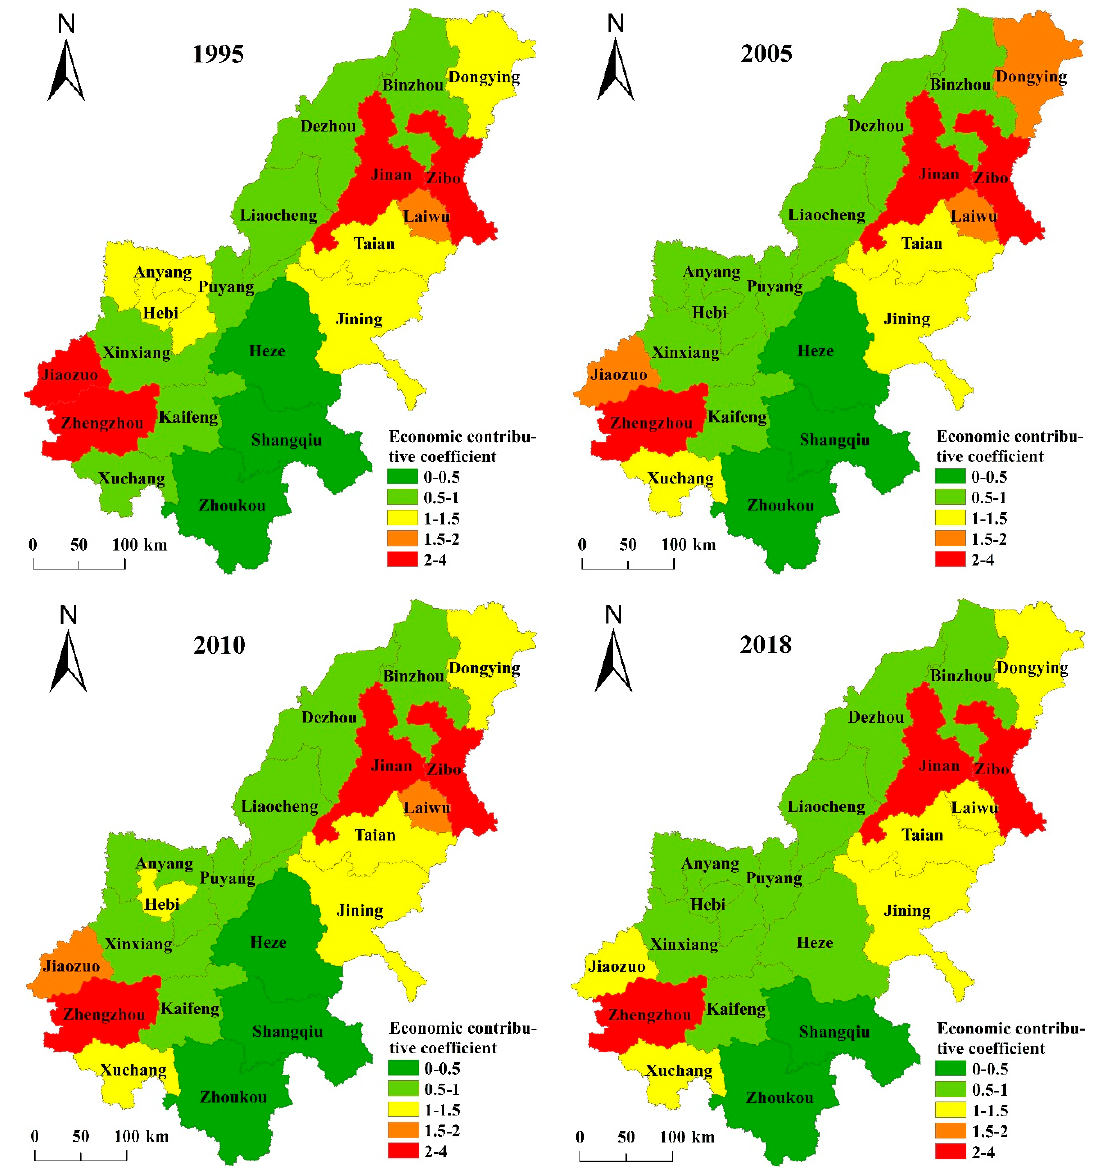
Figure 4. Spatial distribution of the carbon emissions economic contributive coefficient in prefecture- level cities of the lower Yellow River area from 1995 to